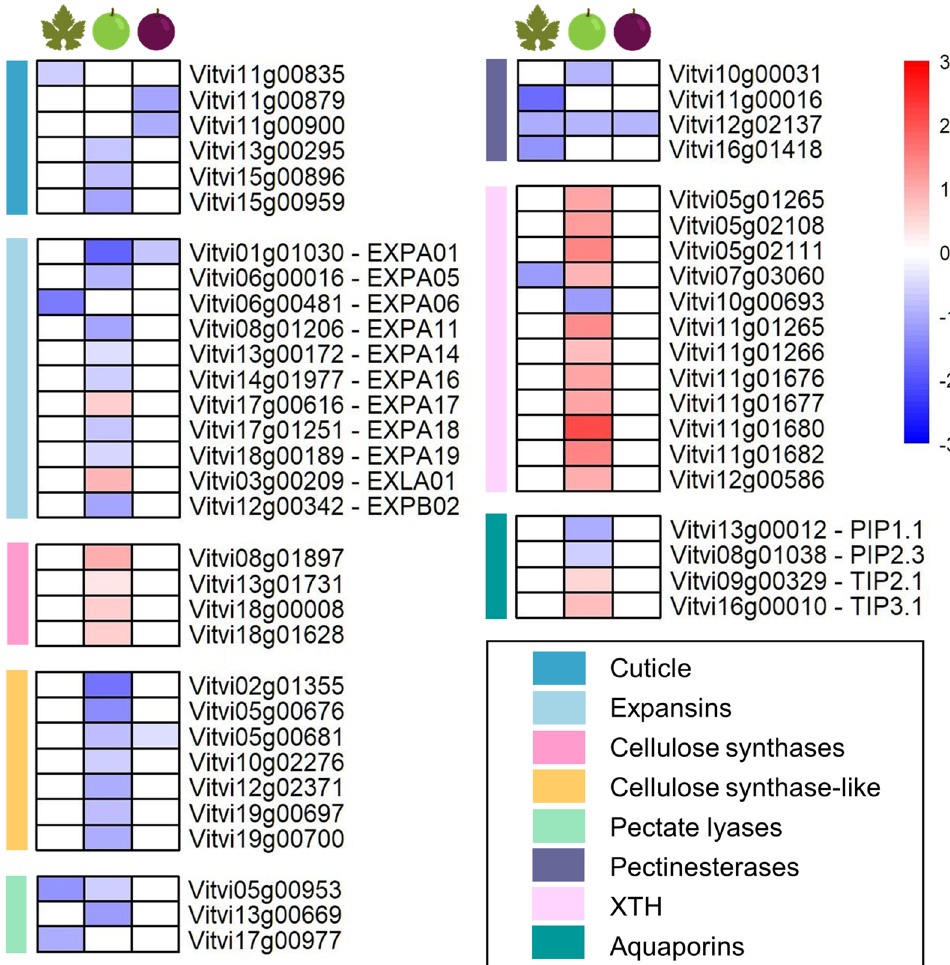
Figure 6. Cell wall and growth-related genes modulated by the ozonated water treatment in leaves (left column), berries at the beginning of ripening (middle column) and berries in mid-ripening (right column) are represented in heatmaps as log 2 FC(OW/C). Red and blue colours indicate up- or down-regulation, respectively. The coloured sidebar on the left displays the class of genes. XTH: xyloglucan